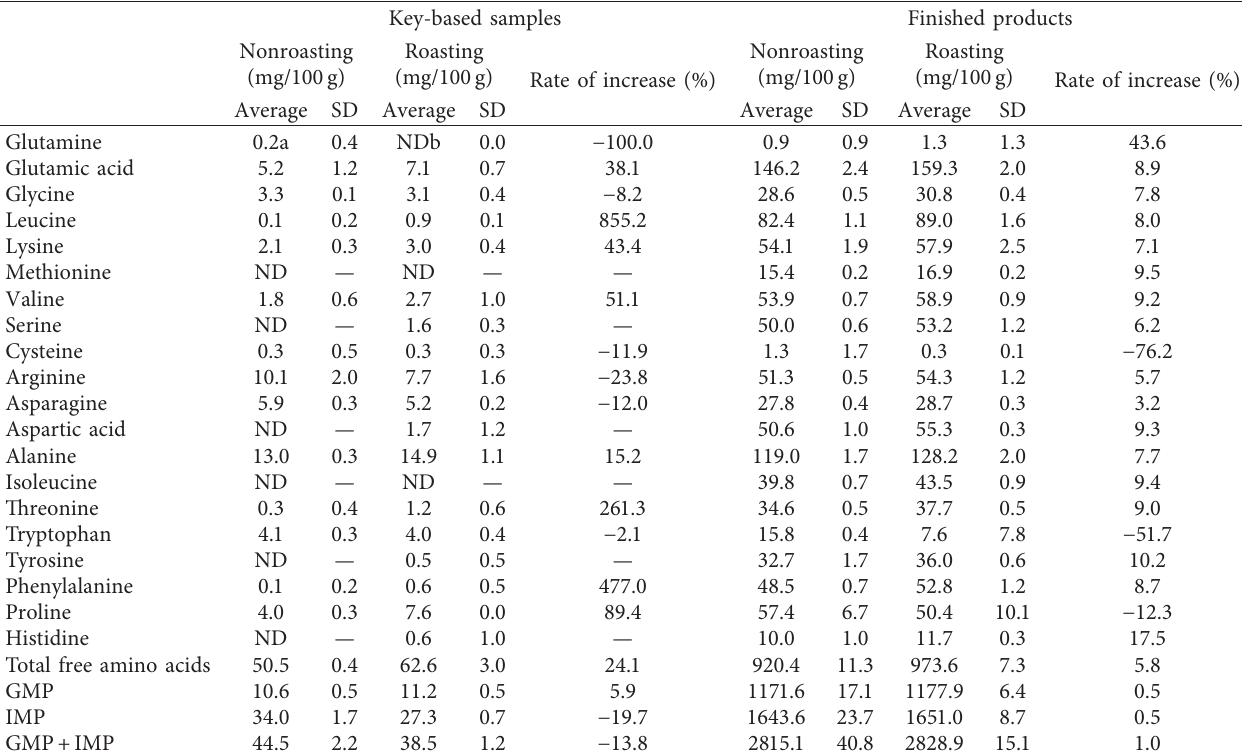
Table 5: Comparison of amino acid and nucleotide (guanosine monophosphate and inosine monophosphate (GMP, IMP)) composition of roasted and nonroasted mixed sauce